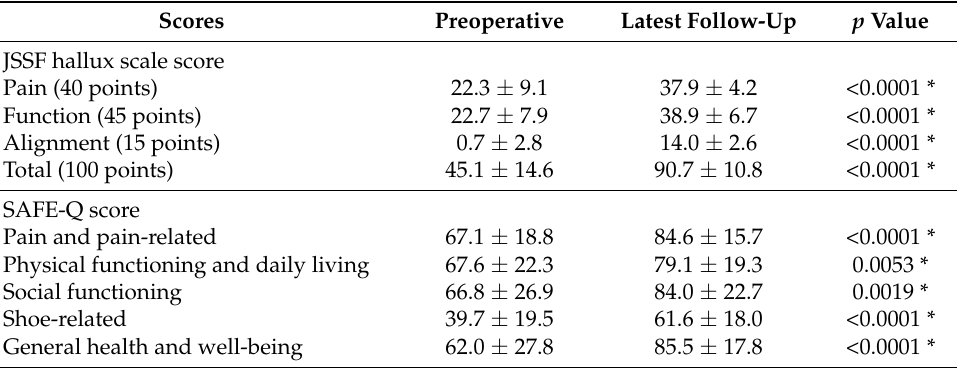
Table 3. Comparisons of the JSSF and SAFE-Q scores before and after